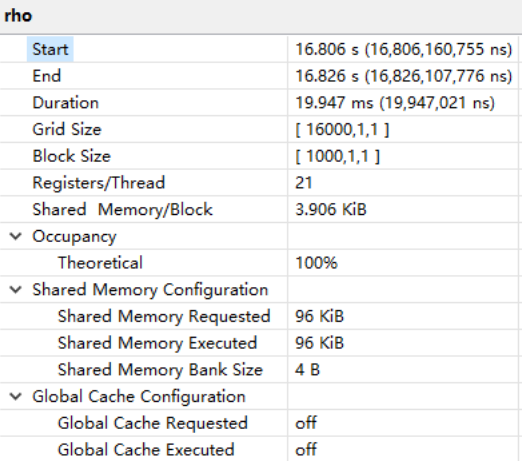
Fig. 9. The GPU kernel properties on calculating the distance matrices.